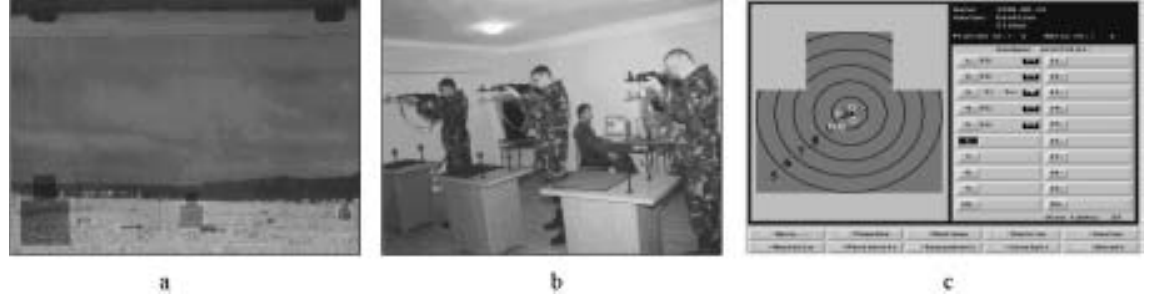
Fig. 9. Laser riflemen trainer LT-2: a – multimedia target view on the screen; b– fire line and working place of instructor; c– information on